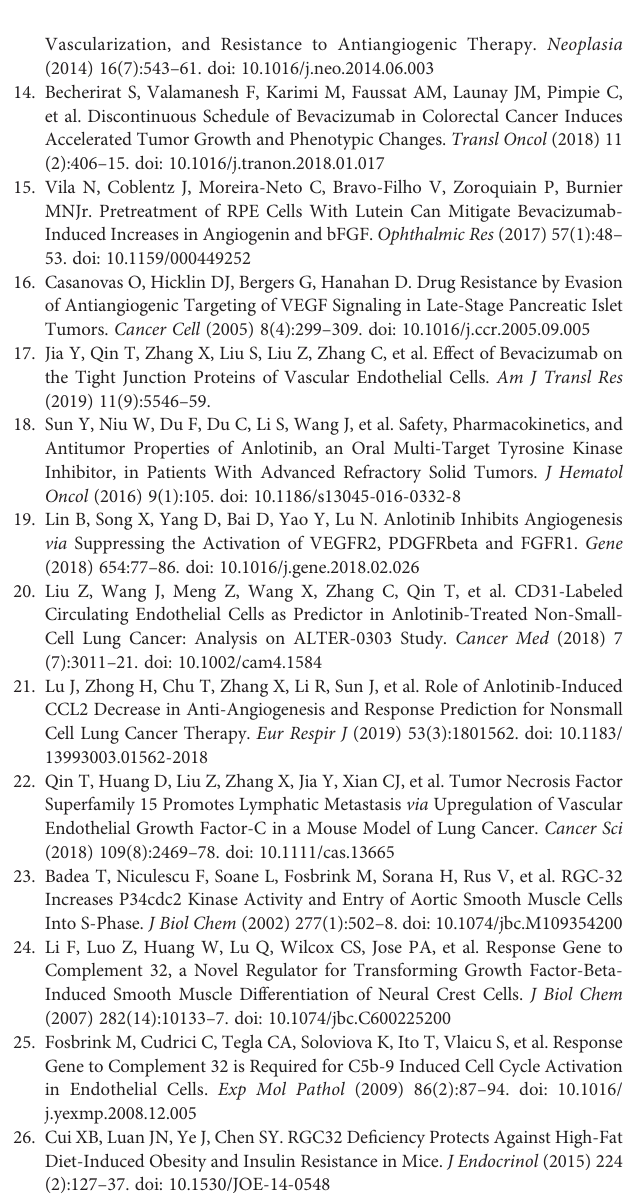
Supplementary Figure 2 | Effect of bevacizumab on cell proliferation. Supplementary Figure 3 | IC50 of anlotinib in A549 and H1299 cells. (A) IC50 in A549 cells. (B) IC50 in NCI-H1299 cells. Supplementary Figure 4 | High-dose bevacizumab up-regulated RGC32 expression in H1299 cells. Western blot analysis of RGC32 expression after treatment of bevacizumab. Bev, bevacizumab. Supplementary Figure 5 | RGC32 expression in different lung adenocarcinoma cell